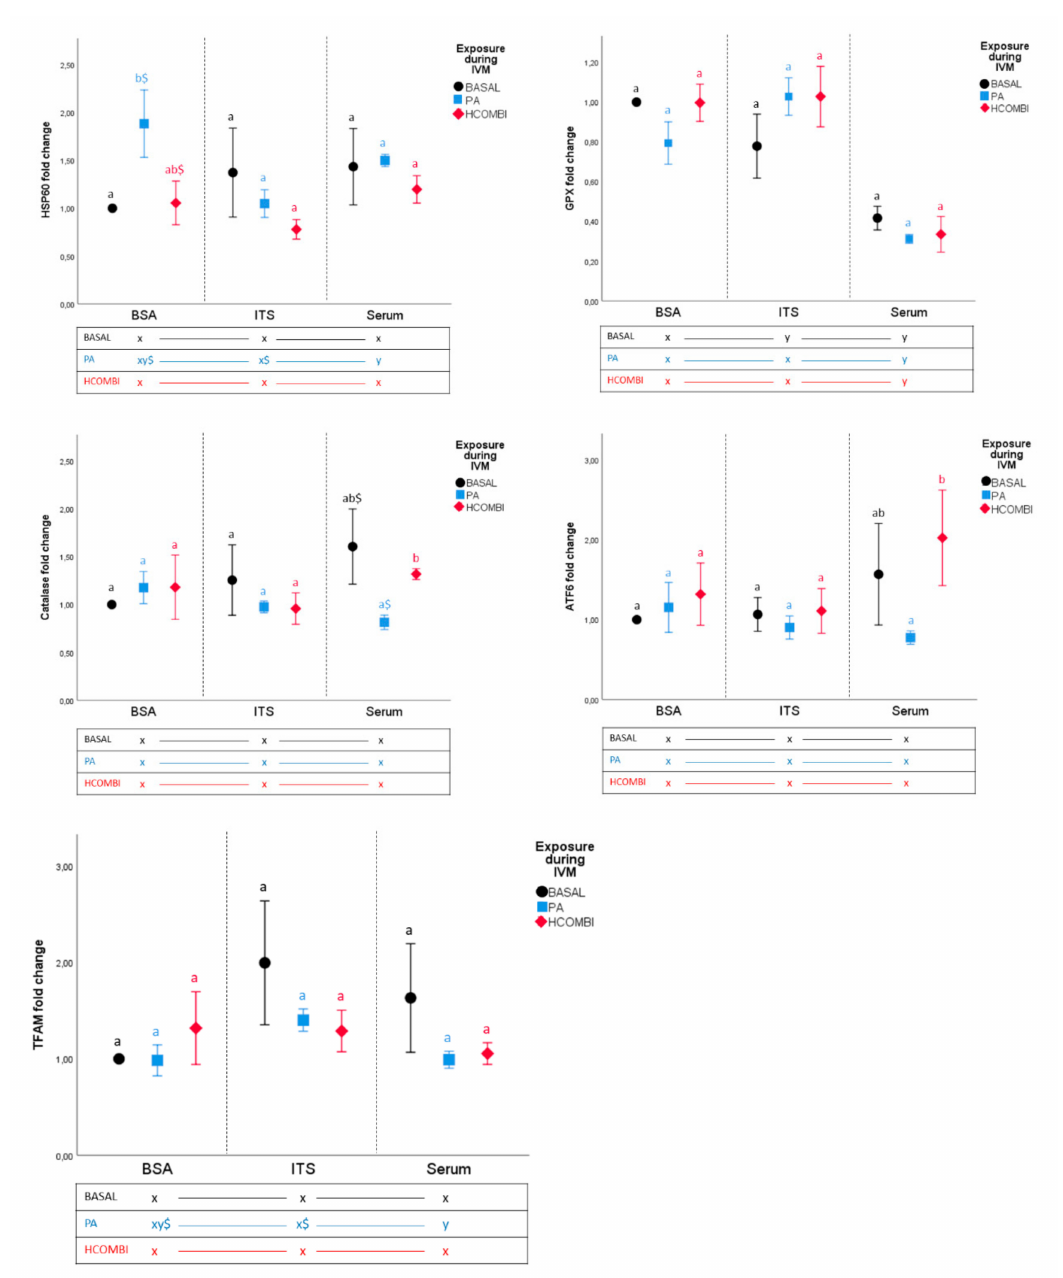
Figure 3. mRNA expression (fold change) of genes related to cellular stress of blastocysts resulting from BASAL-, PA- or HCOMBI-exposed oocytes cultured in serum, BSA and / or ITS. Data are presented as fold change ± SEM. Vertical superscripts (a, b) indicate significant di ff erences between maturation conditions within the same IVC condition ( p < 0.05). Horizontal superscripts (x, y) indicate significant di ff erence between culture conditions within the same IVM condition ( p < 0.05). Values labeled with “$” tend to be di ff erent from each other at p < 0.1 and >